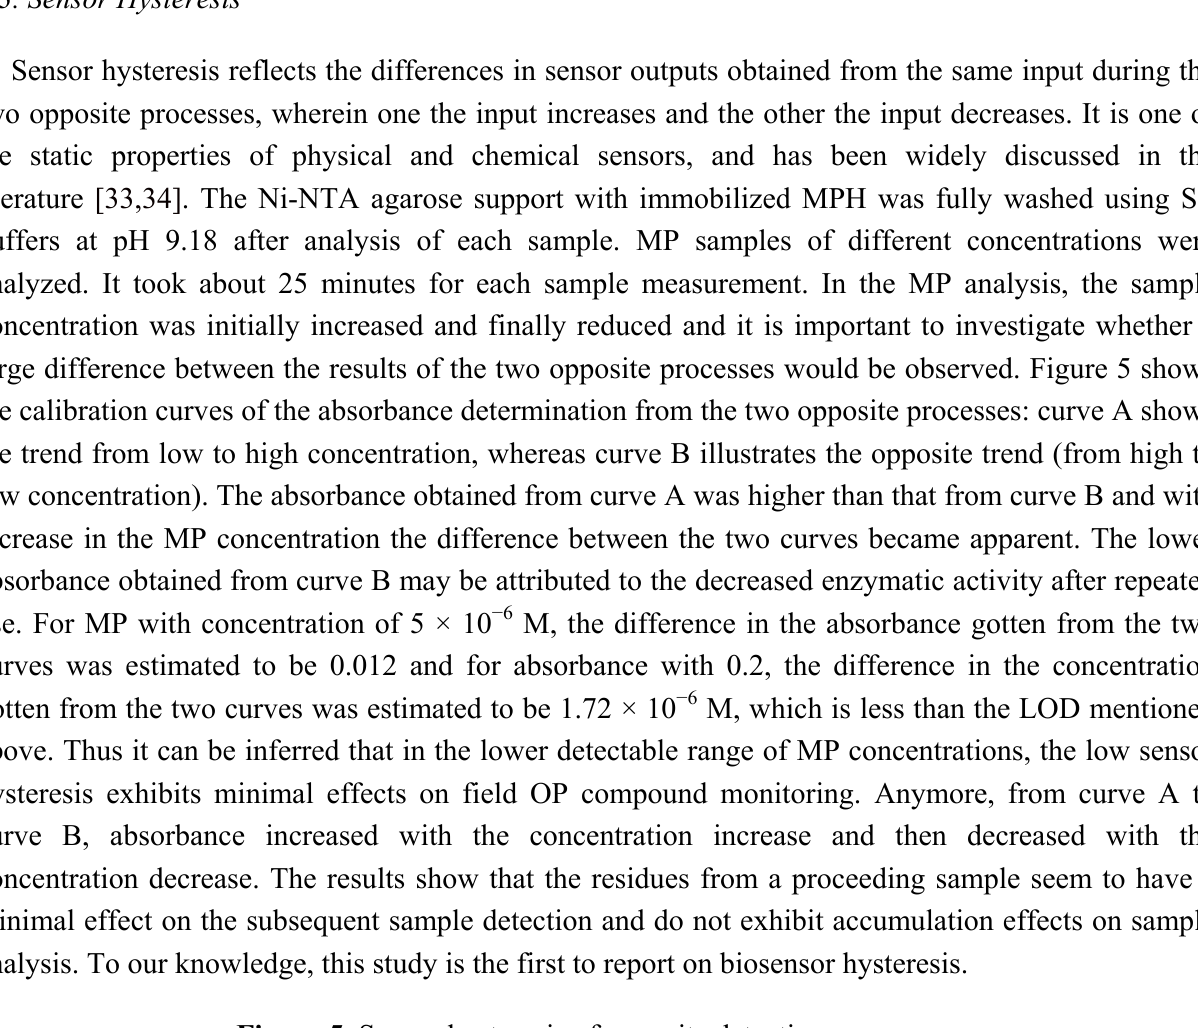
Figure 5. Sensor hysteresis of opposite detection